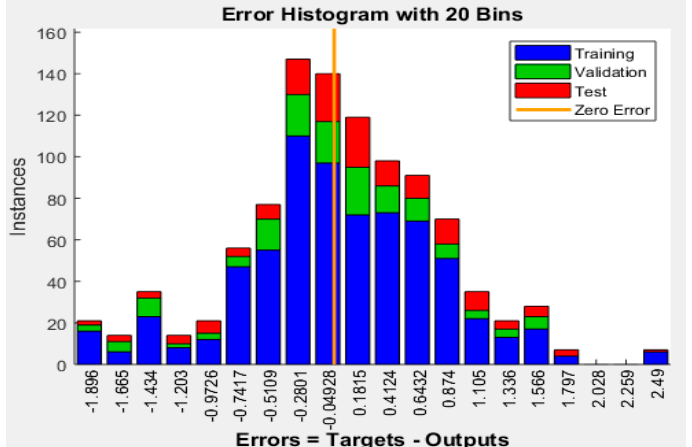
Figure 9. ANN training error histogram.